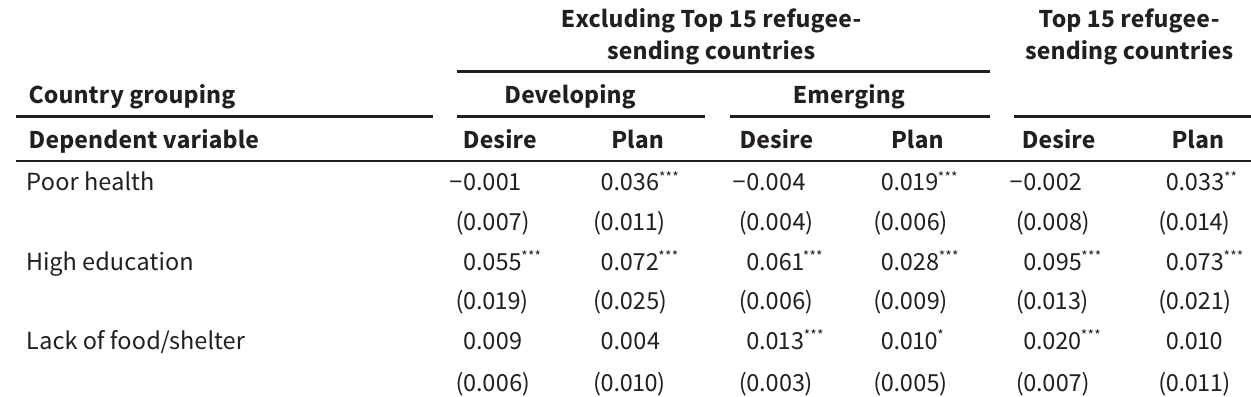
Panel C: Including/excluding Top 15 refugee − sending